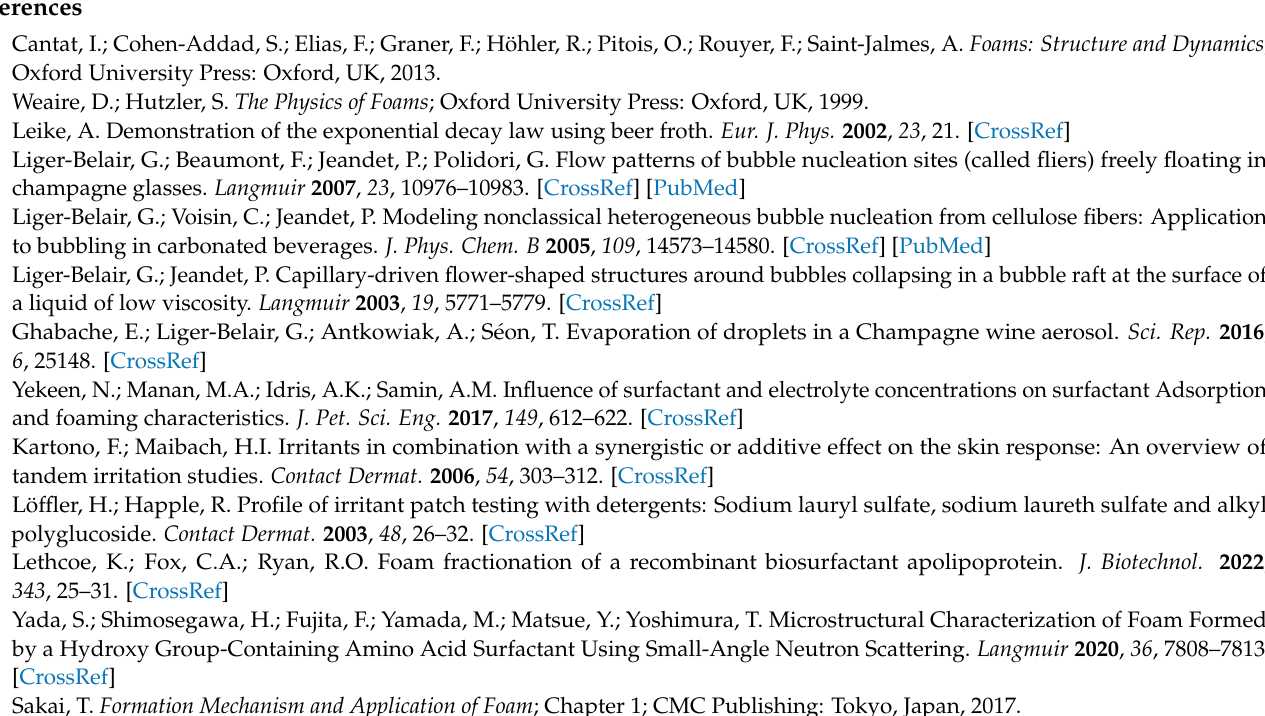
schematic diagram showing the disjoining pressure (solid curve) as a function of the